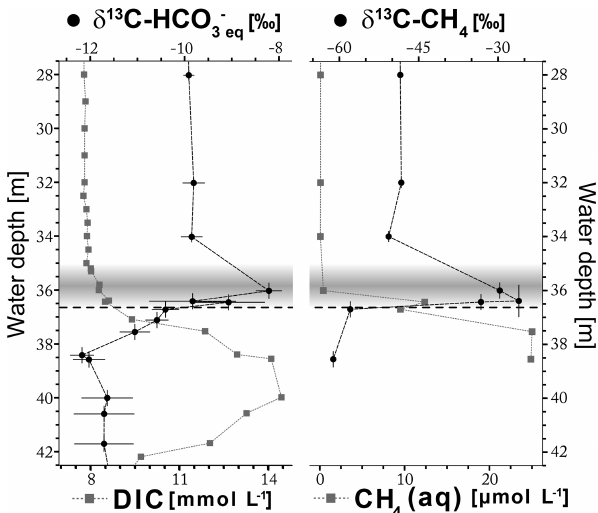
Figure 4. Stable carbon isotope values δ 13 C-HCO − of the dis- 3 eq solved HCO − in equilibrium with δ 13 C-CO 2 values measured in 3 headspace and δ 13 C-CH 4 values of water samples alongside the concentrations of DIC and CH 4 of water samples. The gray band represents the turbid layer in 35–36.6m water depth, and the hori- zontal dashed line indicates the top of the halocline at 36.6m water depth. Horizontal error bars represent 2 σ uncertainties, and vertical error bars indicate up to 0.6m uncertainty of gas samples that were not taken from the sample used to determine chemical parameters (see Sect.